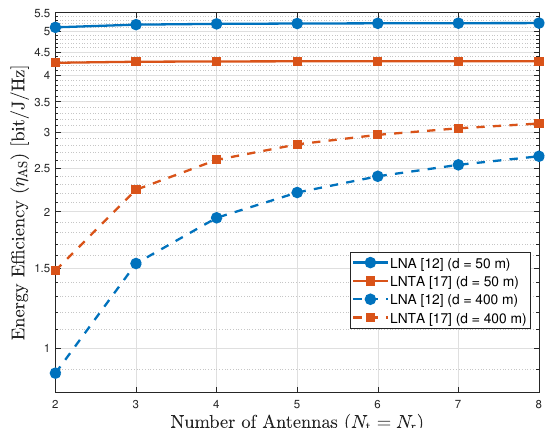
Figure 5. Energy efficiency of the AS scheme as a function of the number of antennas ( N t = N r ), for d = { 50,400 }